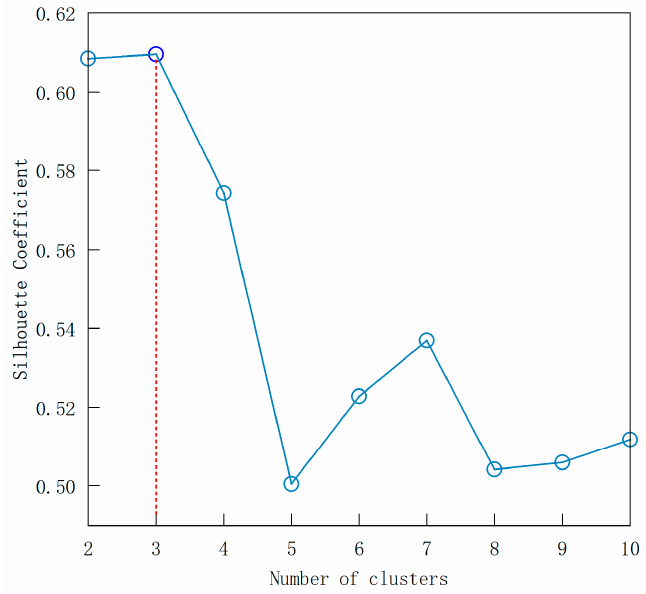
Figure 3. The average silhouette coefficient value computed for different number of clusters.